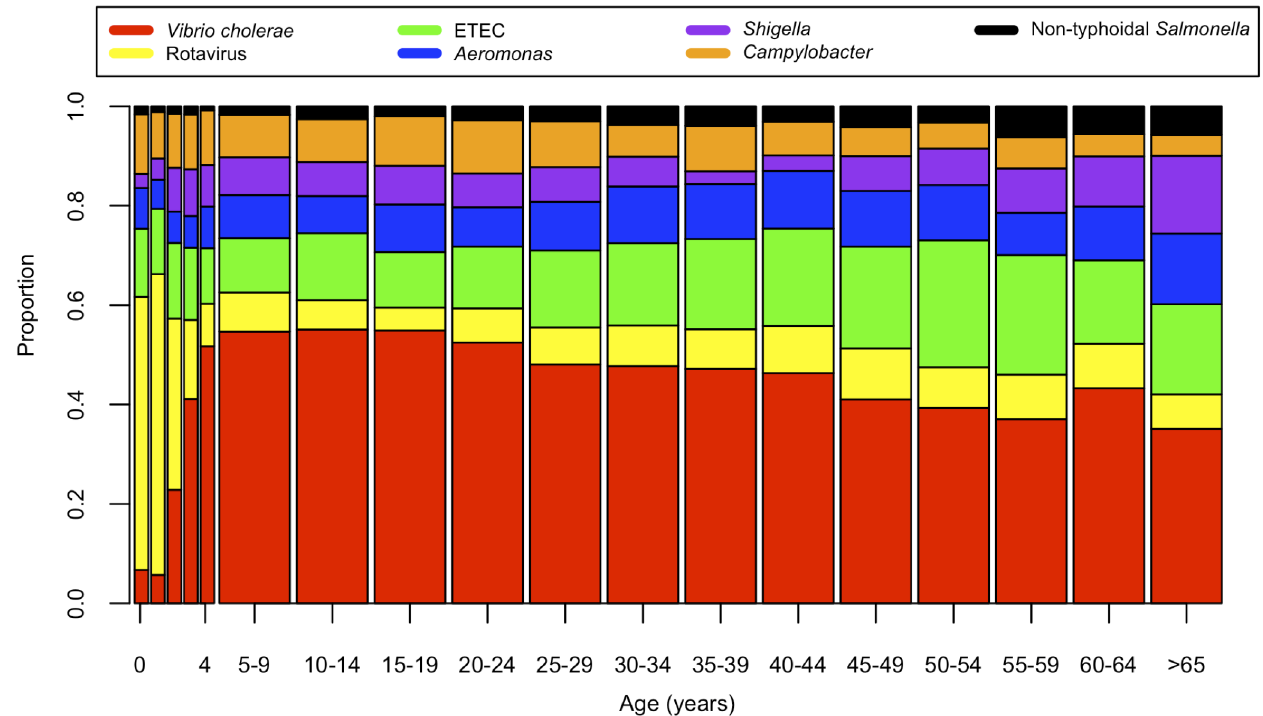
Fig 2. Distribution of high-priority pathogens identified as a function of patient